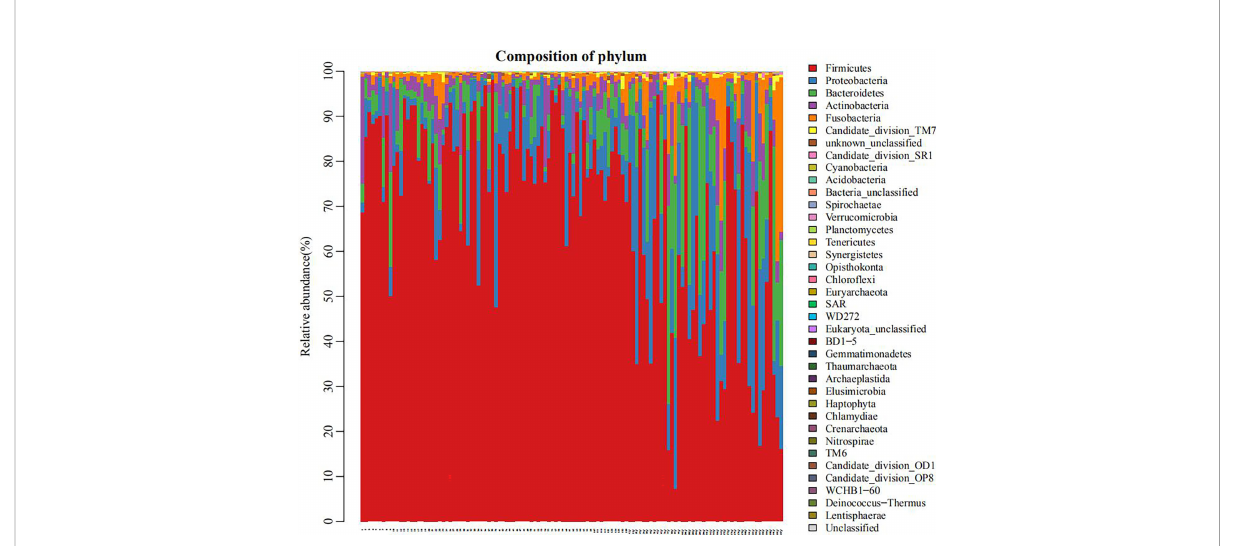
FIGURE 1 Histogram of fl ora distribution (taking phyla for example) The points on the horizontal coordinate represented individual objects of study. Different colors indicated different phyla, and the length of each colored band suggested the amount of speci fi c phylum in an